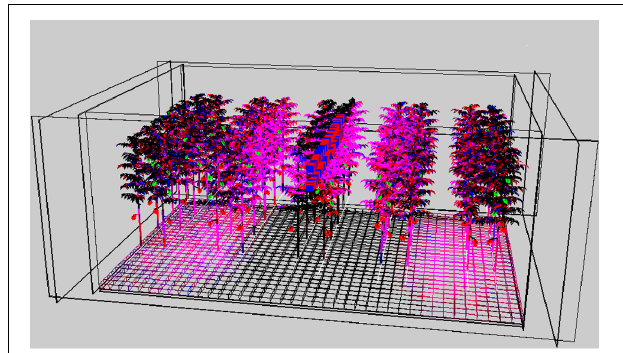
FIGURE 5 | Simulated image of the 3D crop where the intensity of the pink color illustrates the light distribution of 95% red and 5% blue LEDs placed directly above the middle row.